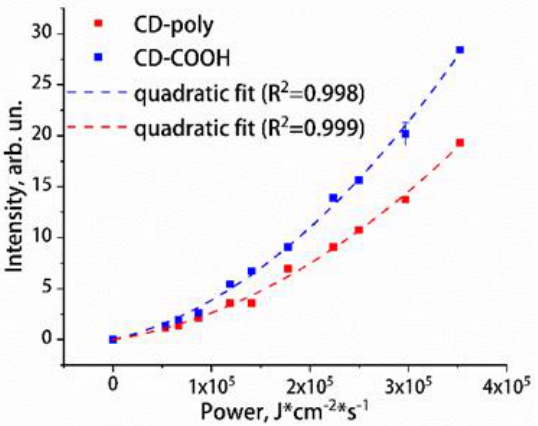
Figure 7. Dependences of the UCL integrated intensity of aqueous solutions of CD-poly and CD- COOH (pH = 11.7) on the power of exciting radiation and approximation of experimental data by quadratic dependences.